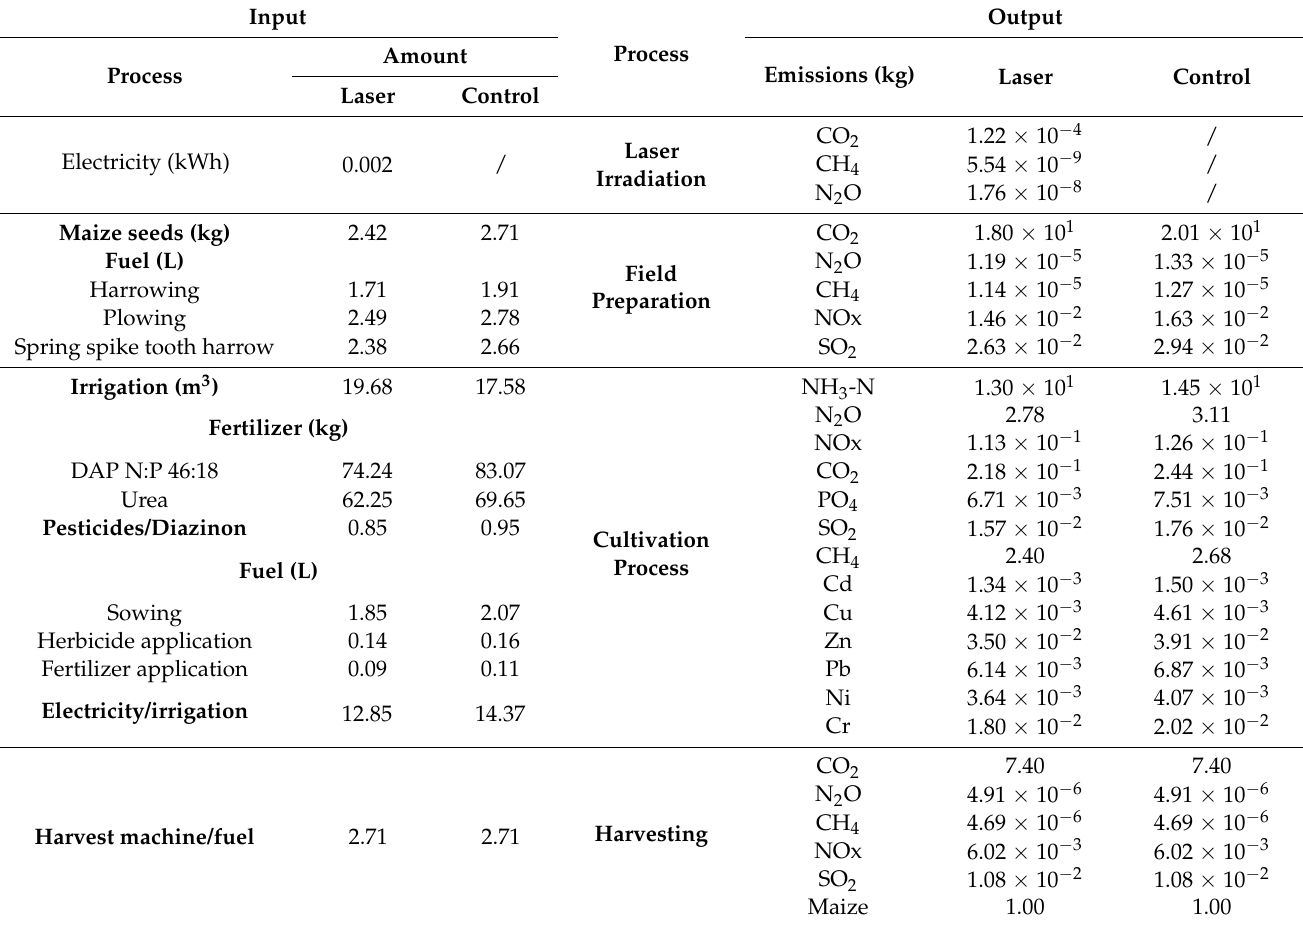
Table 1. LCI for the production of one (1) ton of laser-irradiated and non-irradiated